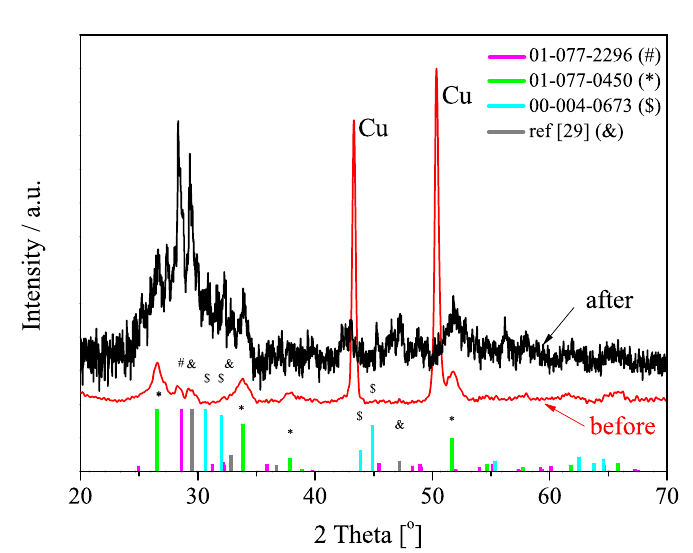
Figure 1. X-ray diffraction (XRD) of SnO x /CHI before ( ) and after ( ) galvanostatic